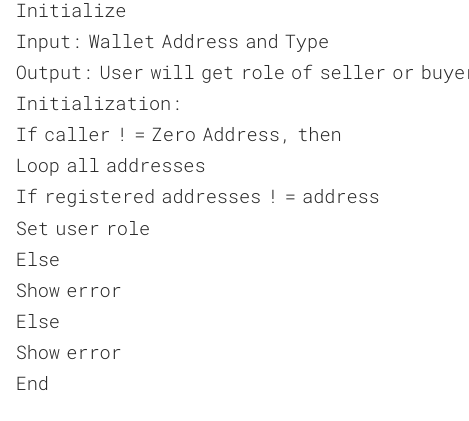
Algorithm 1. Set user type.